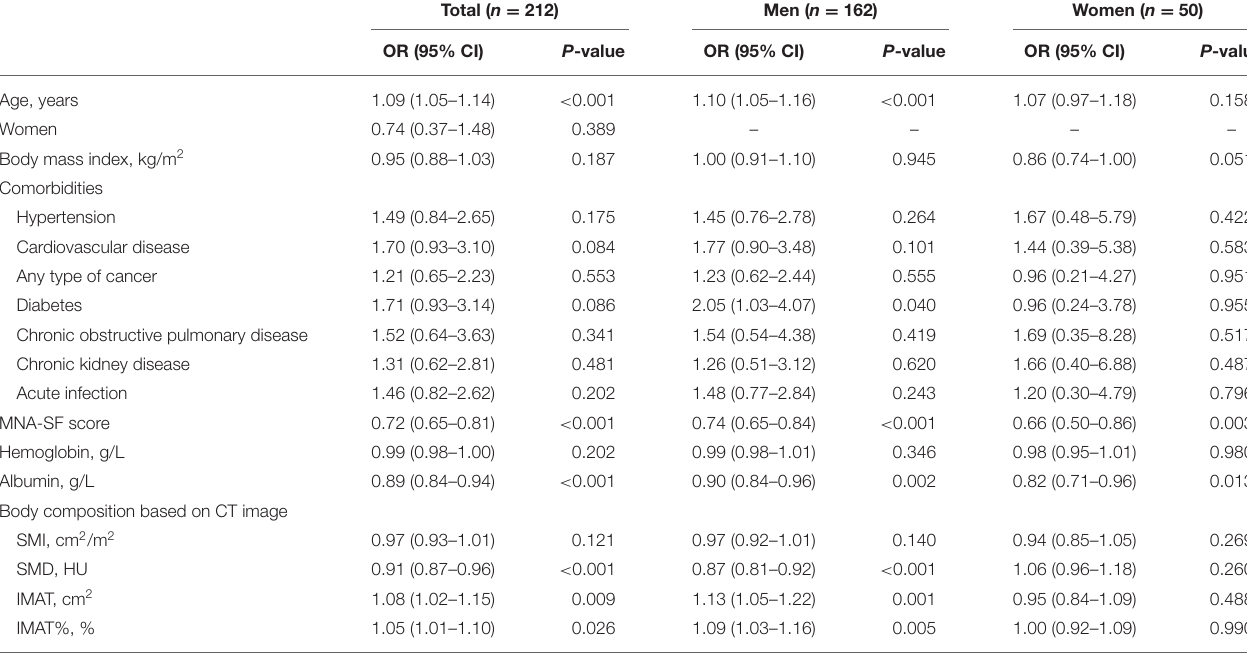
TABLE 2 | Univariate logistic analyses to explore the association between ADL disability and different variables.